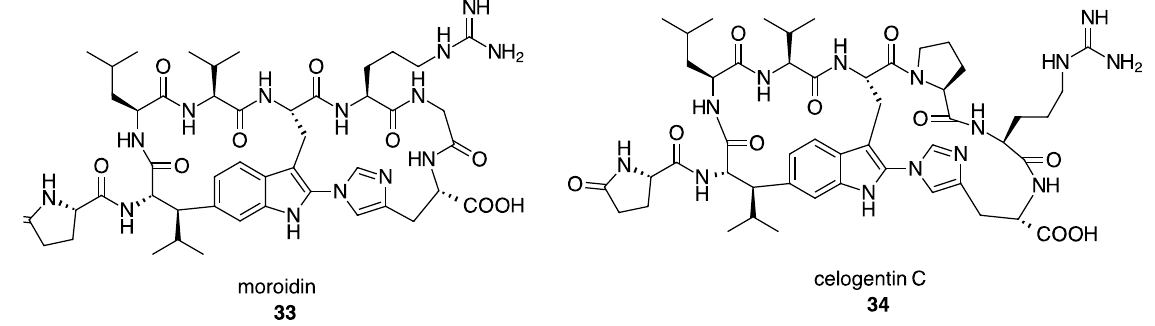
Figure 1. Structures of the peptide-based moroidin ( 33 ) and celogentin C ( 34 ) synthesized in planta [ 60].